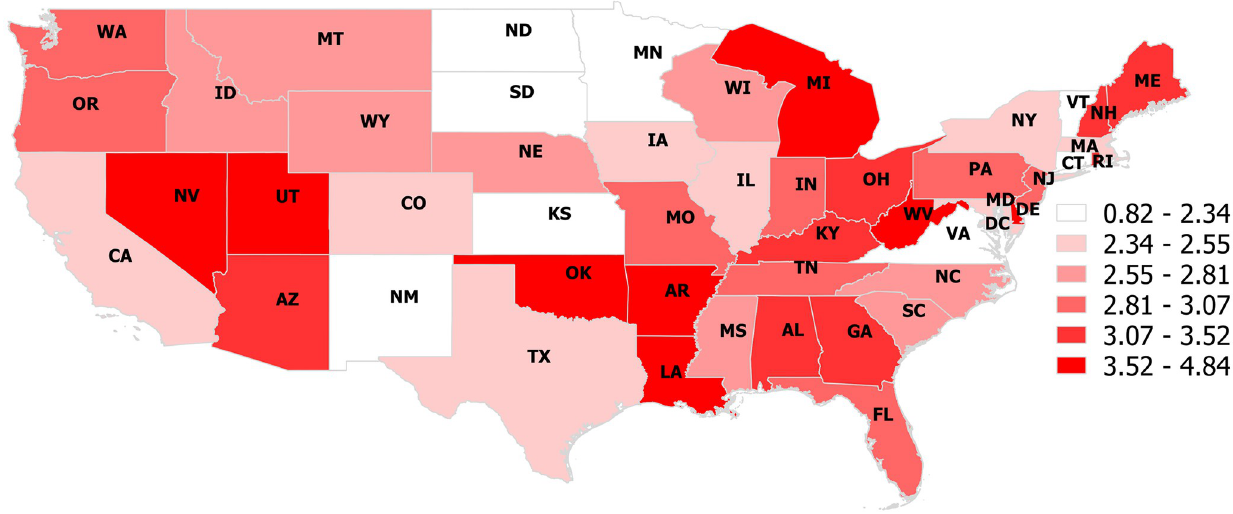
Fig 1. Choropleth map illustrating the proportion of dog-associated poisoning calls to the Animal Poison Control Center that were related to an opioid poisoning in each continental US state (2005–2014).